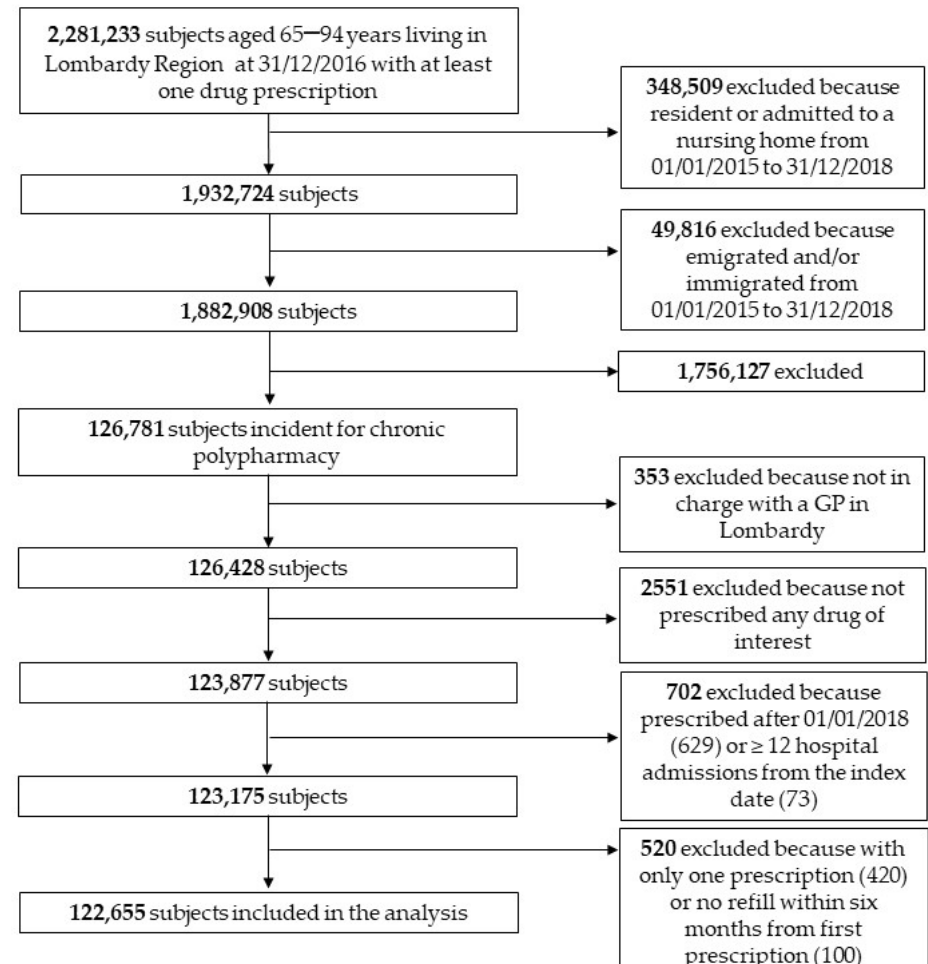
Figure 2. Study flow-chart.